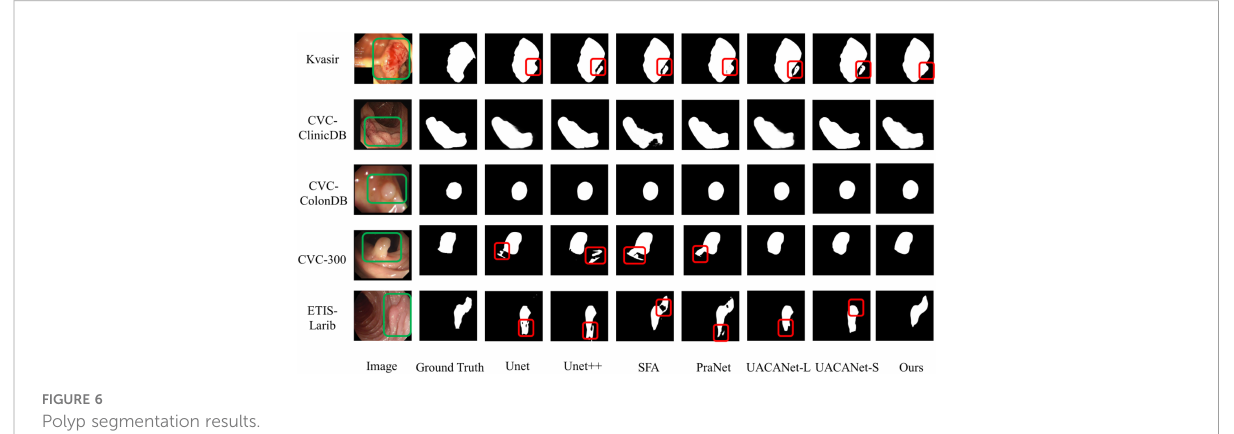
FIGURE 6 Polyp segmentation